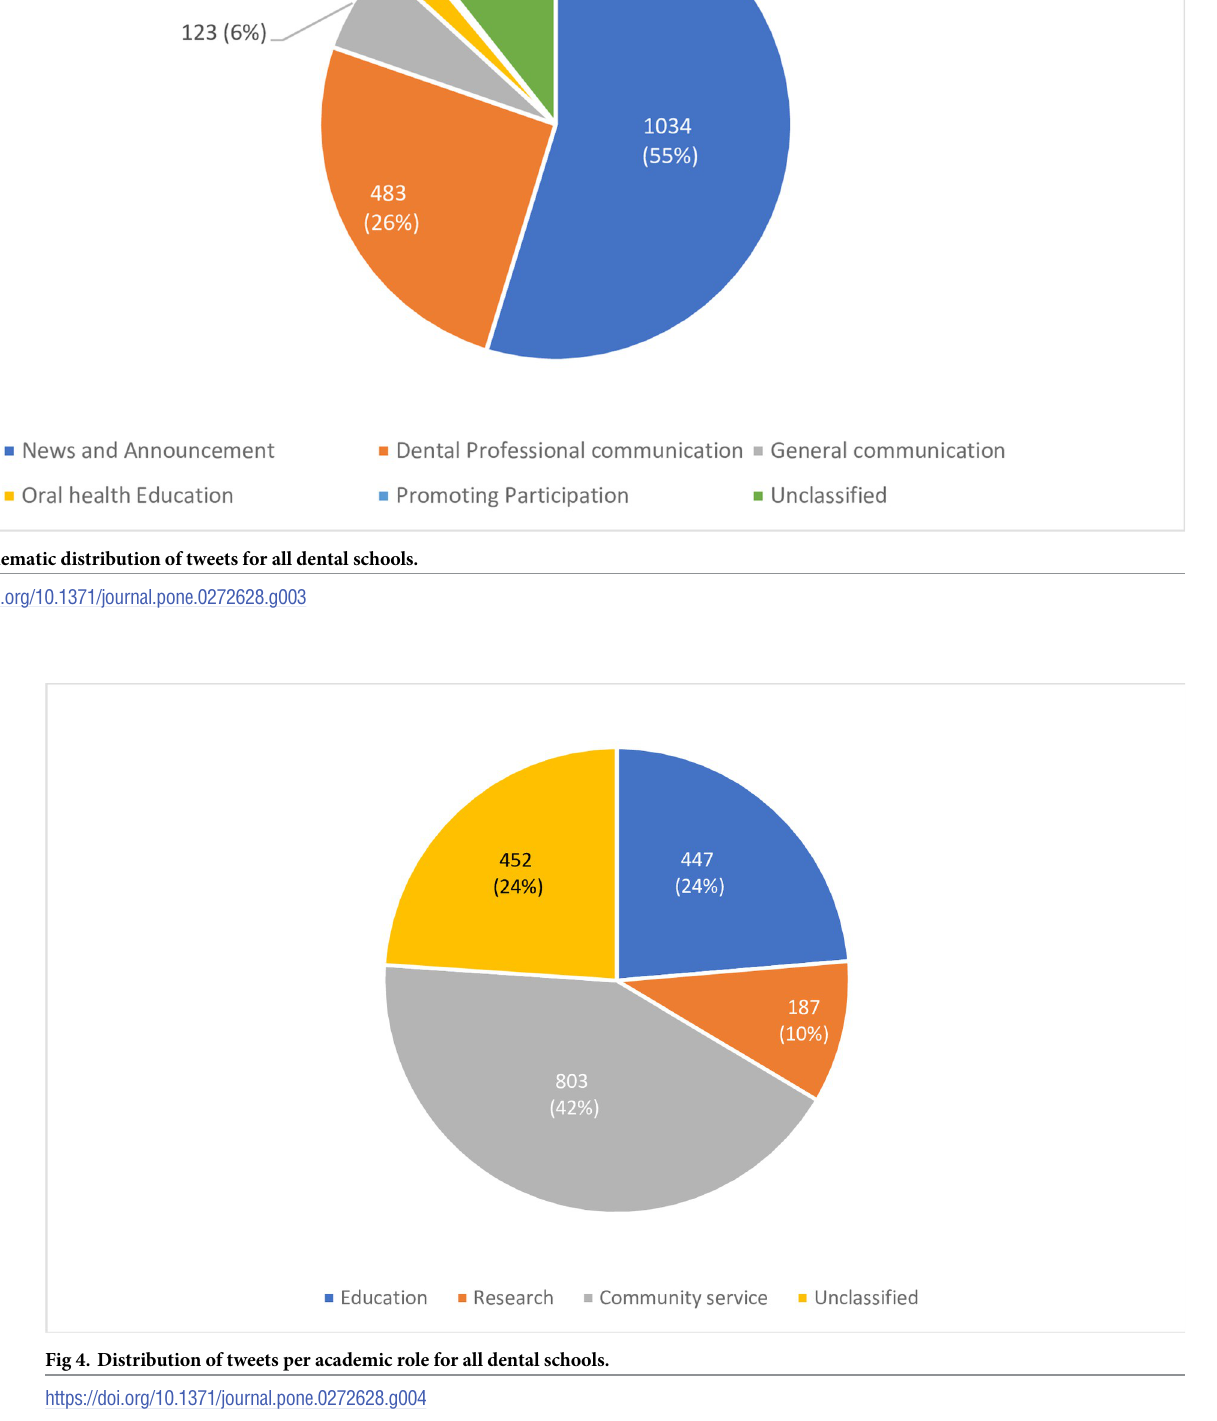
PLOS ONE | https://doi.org/10.1371/journal.pone.0272628 September 8,